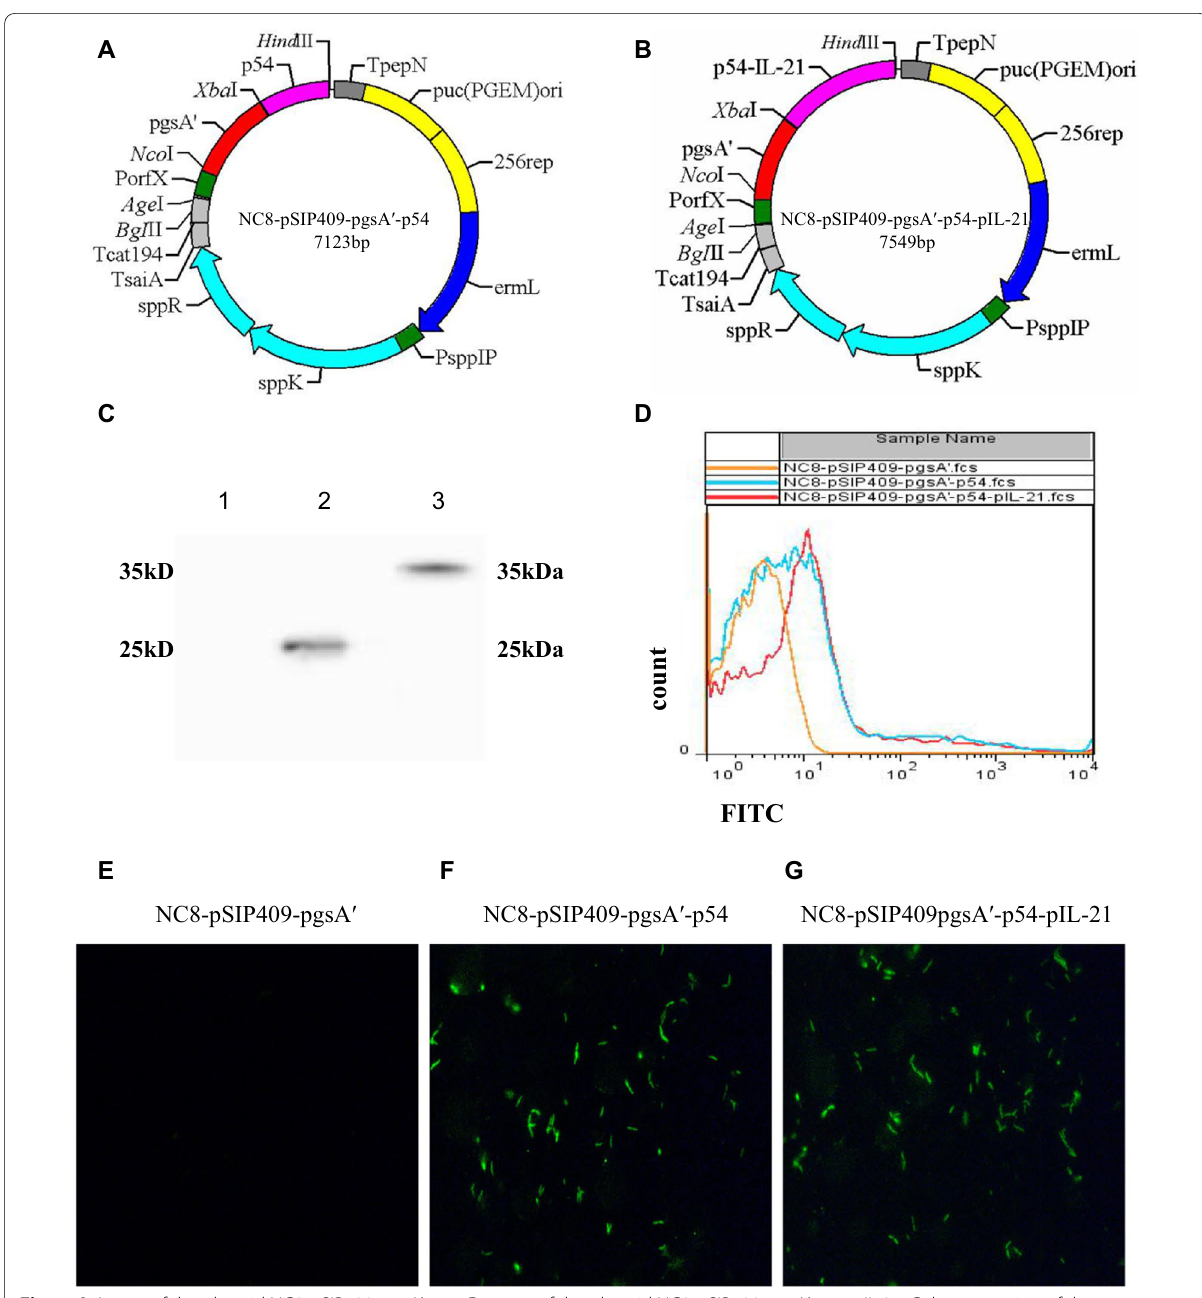
Fig. 1 A A map of the plasmid NC8‑pSIP409‑pgsA’‑p54; B a map of the plasmid NC8‑pSIP409‑pgsA’‑p54‑pIL‑21; C the expression of the recombinant L. plantarum ASFV p54 protein and p54‑pIL‑21 fusion protein was verified by Western blot, lane 1: NC8‑pSIP409‑pgsA’, lane 2: NC8‑pSIP409‑pgsA’‑p54, lane 3: NC8‑pSIP409‑pgsA’‑p54‑pIL‑21; D the expression of recombinant Lactobacillus plantarum was verified by immunofluorescence; E the anchored expression of the ASFV p54 protein and p54‑pIL‑21 fusion protein on the surface of Lactobacillus